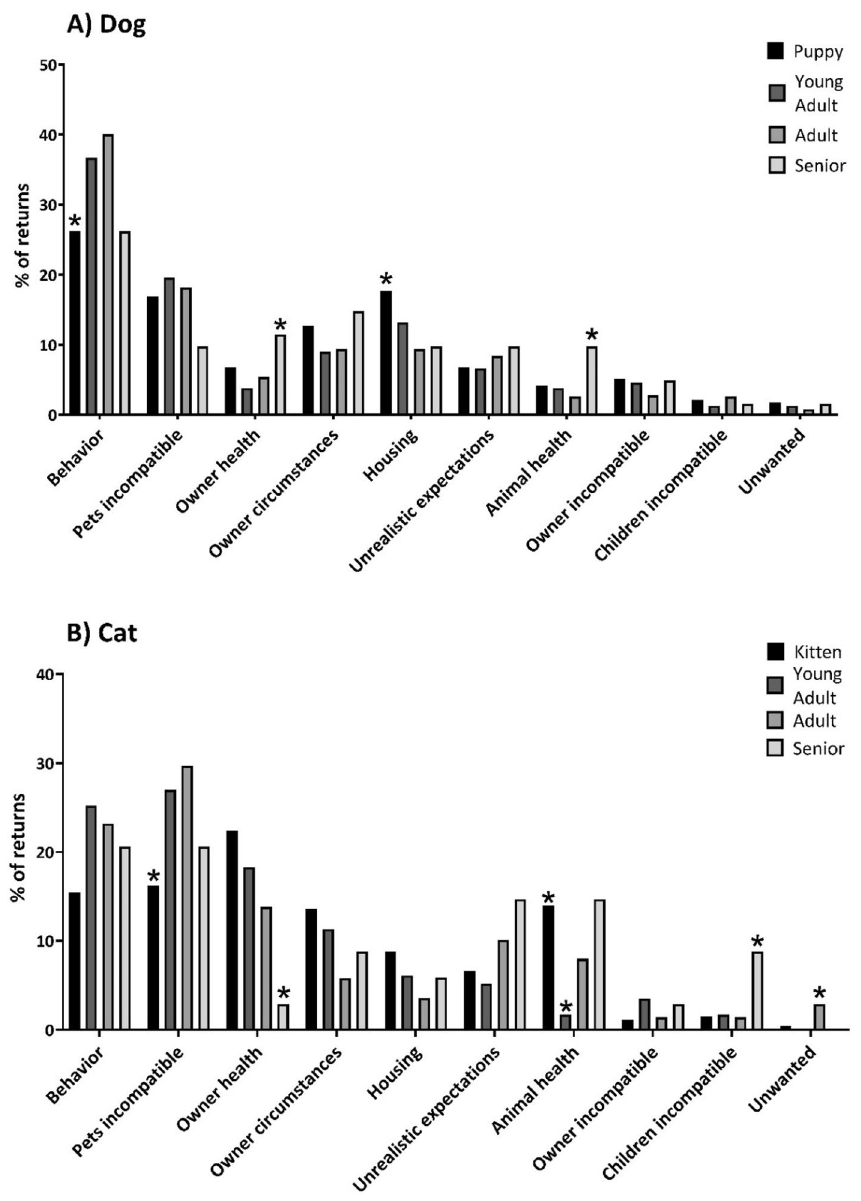
Figure 2. Categorized return reasons by age group. *Denotes statistical significance ( p <